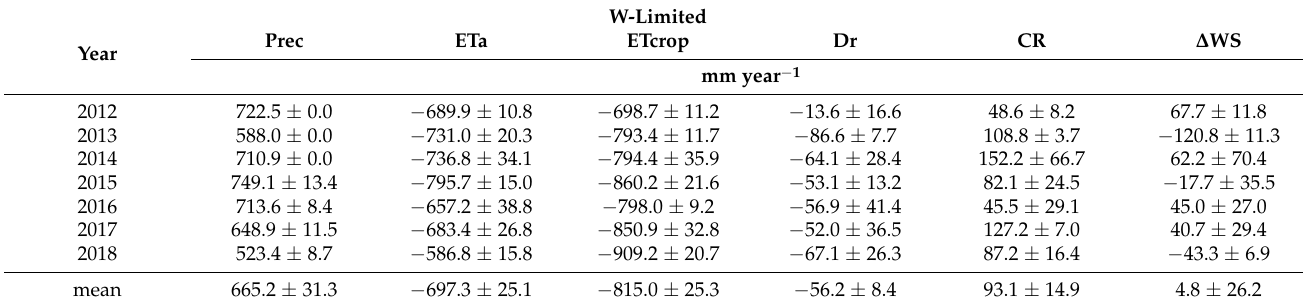
Table A3. Components of the lysimeter annual soil water balance—mean values and standard deviations, ± , in mm year − 1 —for Rollesbroich soil in Selhausen, the water-limited site (W-limited) between 2012 and 2018 with the precipitation (Prec), actual evapotranspiration (ETa), crop-height-adjusted reference evapotranspiration (ETcrop), drainage (Dr), capillary rise of water (CR), and change in soil water storage ( ∆ WS); negative values represent a loss of water for the system; row “mean” gives the means of the annual values for the period 2012–2018; the inter-annual variability is represented by the standard error of the annual mean values.